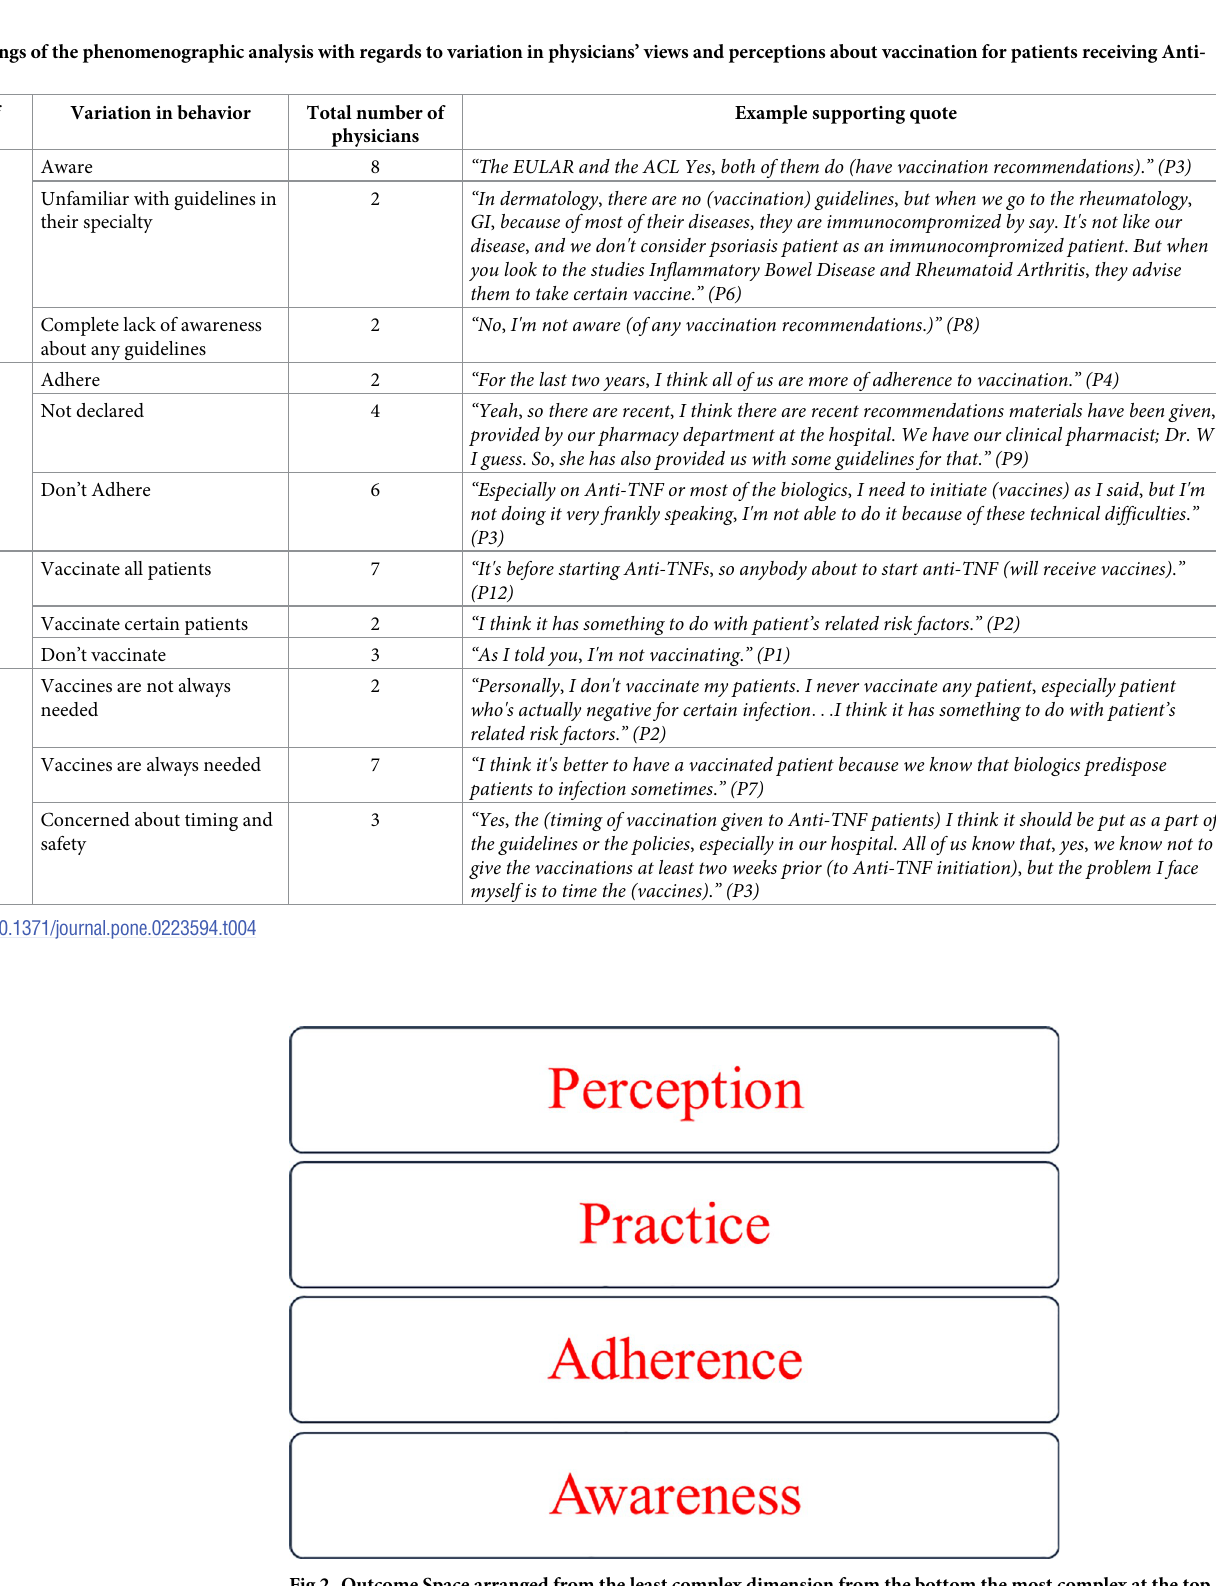
PLOS ONE | https://doi.org/10.1371/journal.pone.0223594 October 4,